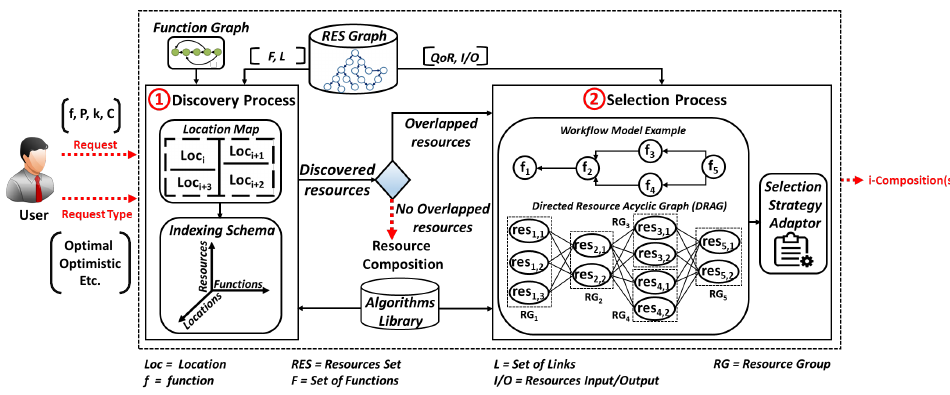
Figure 2. Overview of the resource discovery and selection